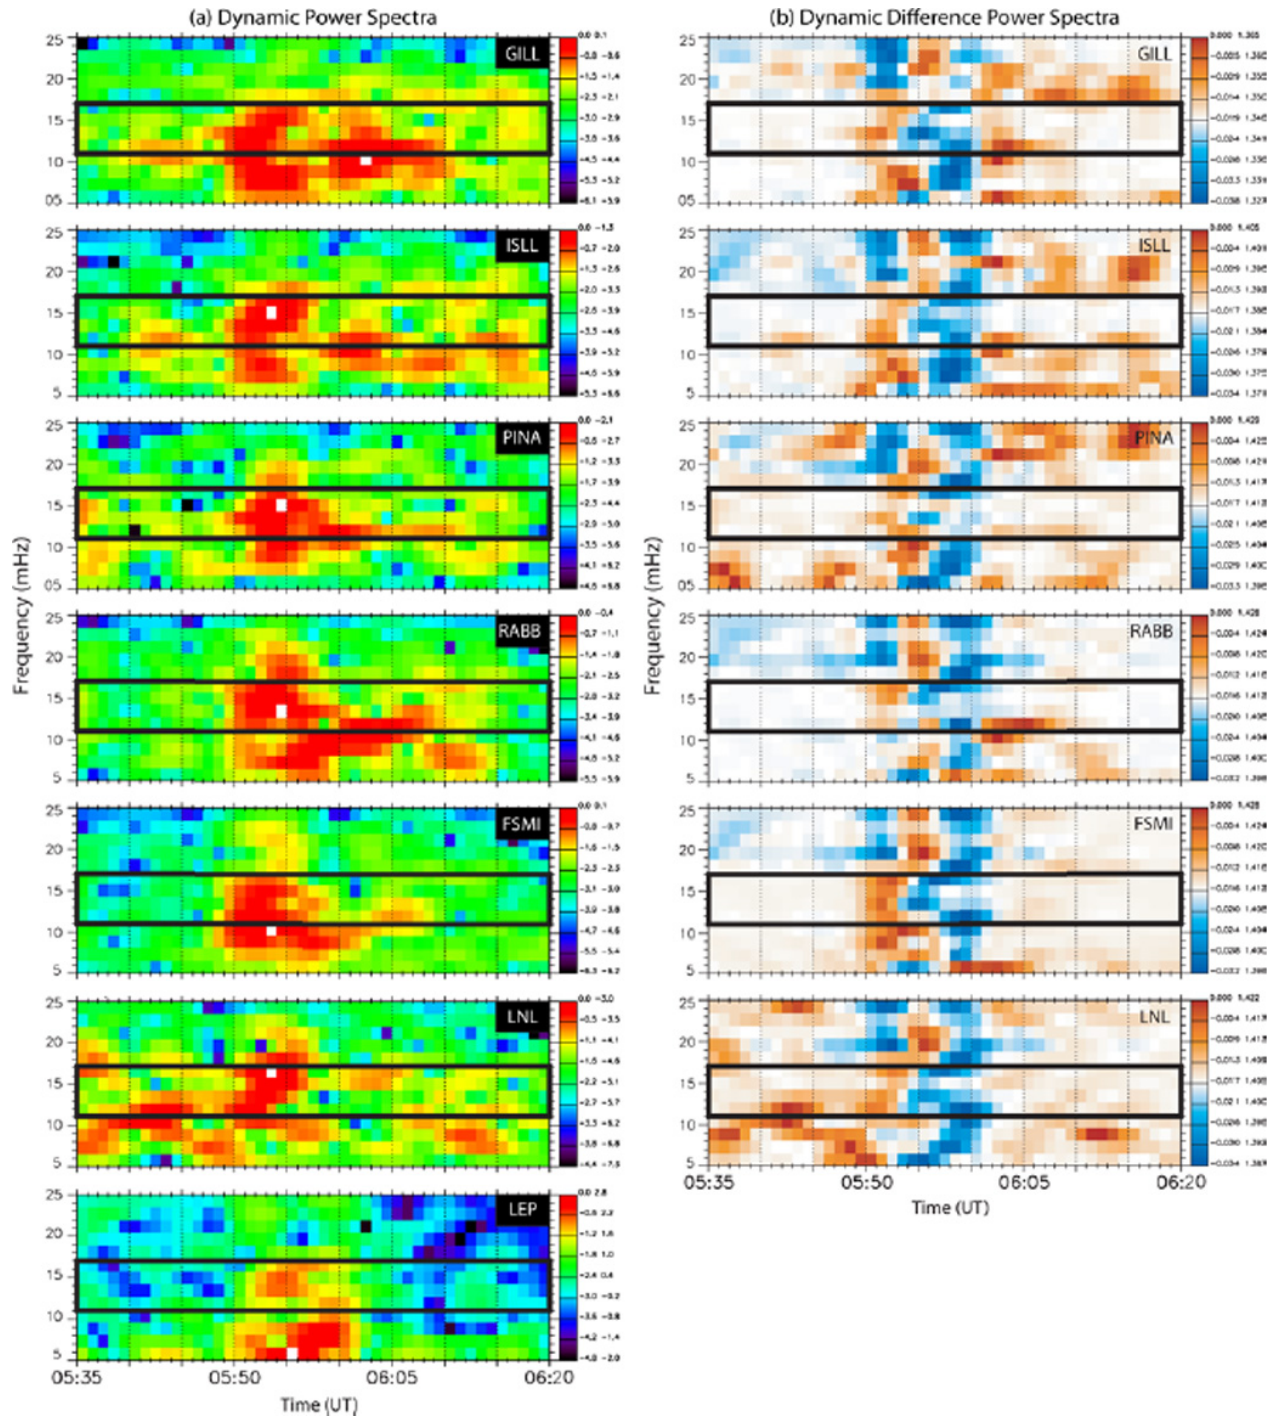
Fig. 4. (a) The H-component normalised dynamic power spectra at select CARSIMA magnetometers, the LNL magnetometer and the LEP v ⊥ x plasma flow. The color bar illustrates the normalised power at each station. (b) The dynamic difference spectra between the normalised power spectra in the H-component magnetic field at LNL, and selected CARISMA stations and the LEP v ⊥ x plasma flow. The color bar depicts the difference between the power observed at a ground-based magnetometer and that observed in v ⊥ x . Red indicates power from the magnetometer dominates, blue shows that power in the LEP v ⊥ x plasma flow dominates and white shows similar power is observed in both the H-component magnetic field and v ⊥ x flow at Geotail. The black box in both (a) and (b) highlights the frequency band of interest, between